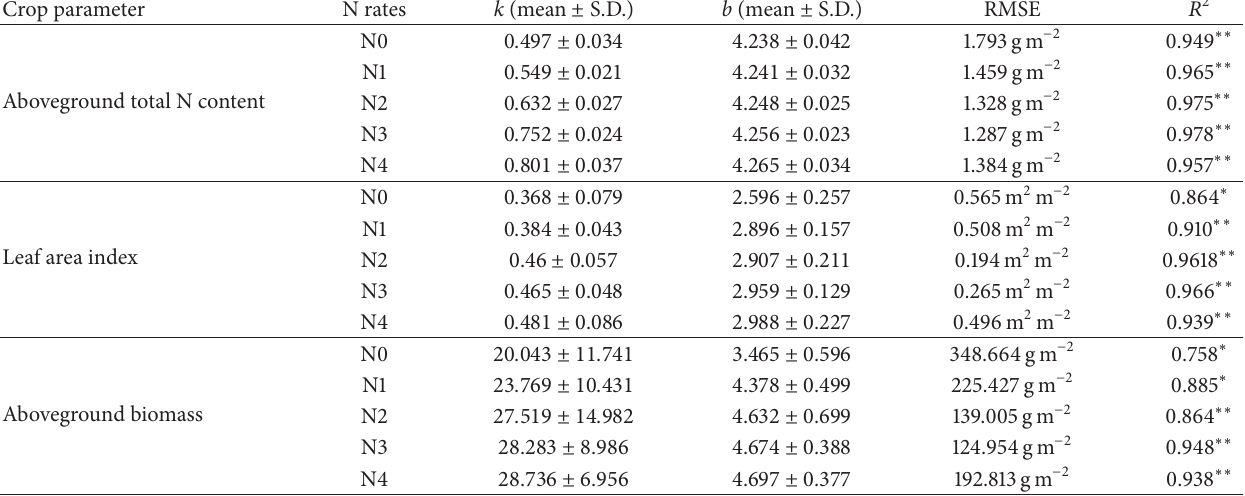
Table 4: Exponential equations showing the relationships between canopy cover and the three crop properties of two cotton cultivars grown with five N rates in experiment 1. Crop parameter N rates k (mean ± S.D.)